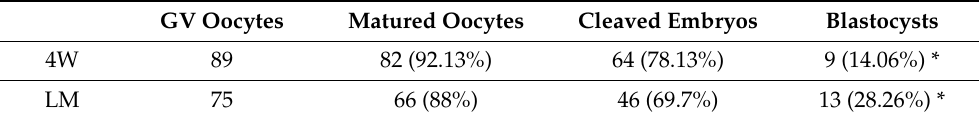
Table 3. In vitro maturation, fertilization and development to blastocyst stage of prepubertal sheep oocytes cultured in liquid marble (LM) microbioreactor and control (4W) systems. * p = 0.066, chi-squared